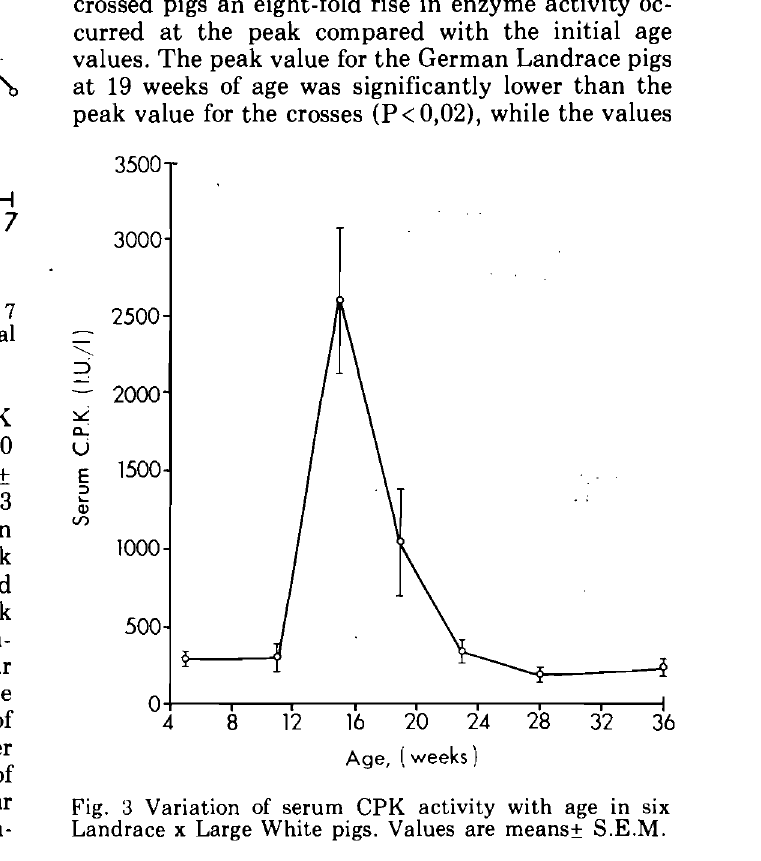
Fig. 3 Variation of serum CPK activity with age in six Landrace x Large White pigs. Values are means±